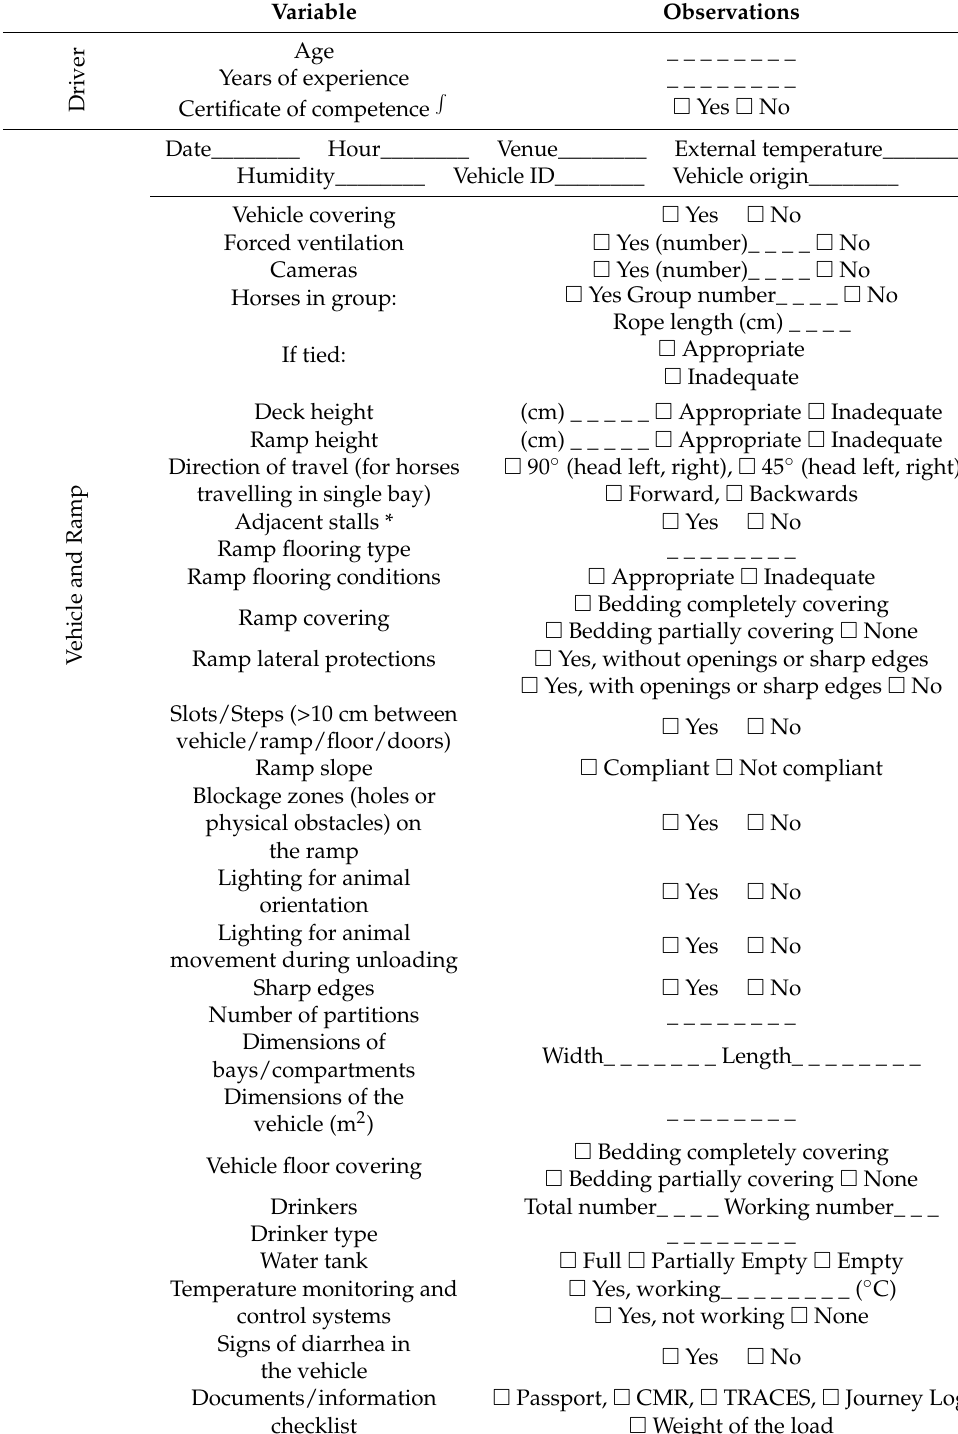
Table 3. The checklist used after unloading to gather information about the driver’s age and experi- ence, vehicle and ramp characteristics, and documentation at arrival in a Southern Italy slaughter- house (modified from Messori et al.